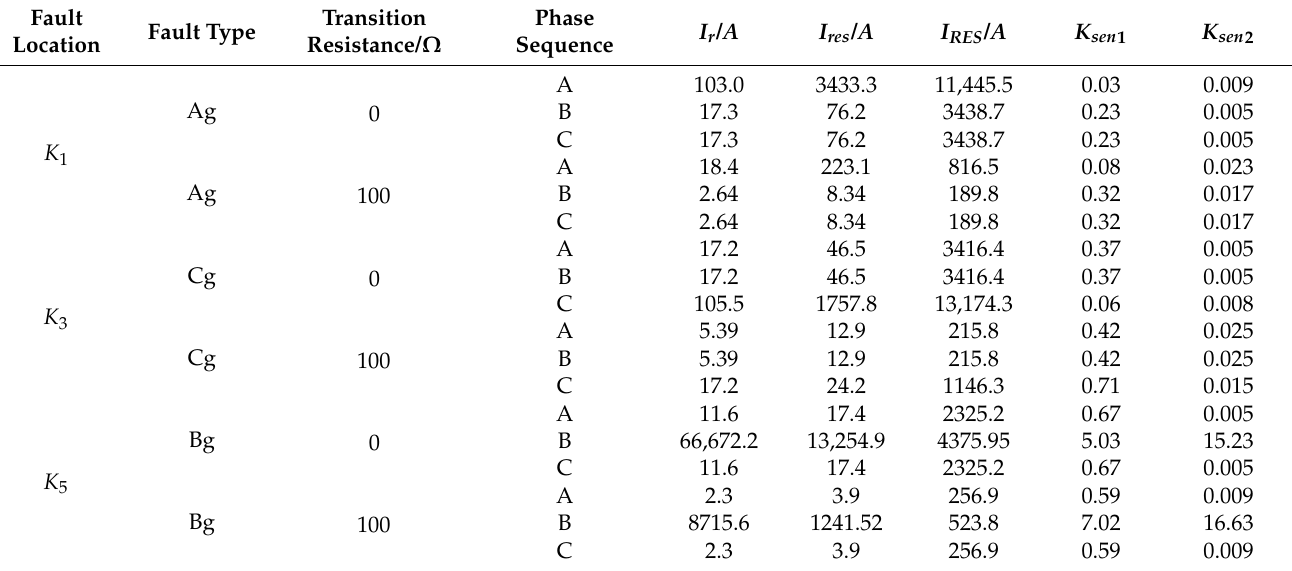
Table 1. Comparison of single-phase ground fault simulation results of two algorithms. Fault Location